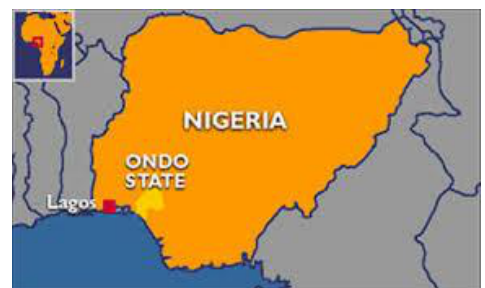
Figure 1. Showing location of Ondo State in Nigeria and Africa.